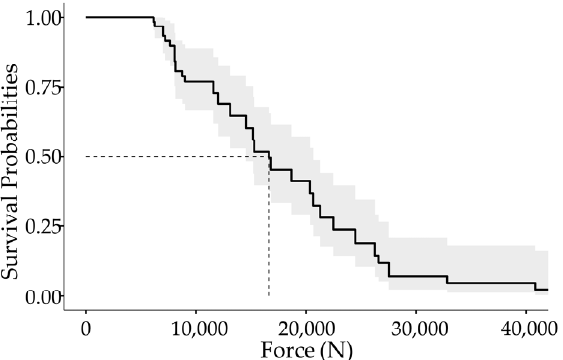
Figure 14. Survival probability curve based on the contact force and pelvic fracture.